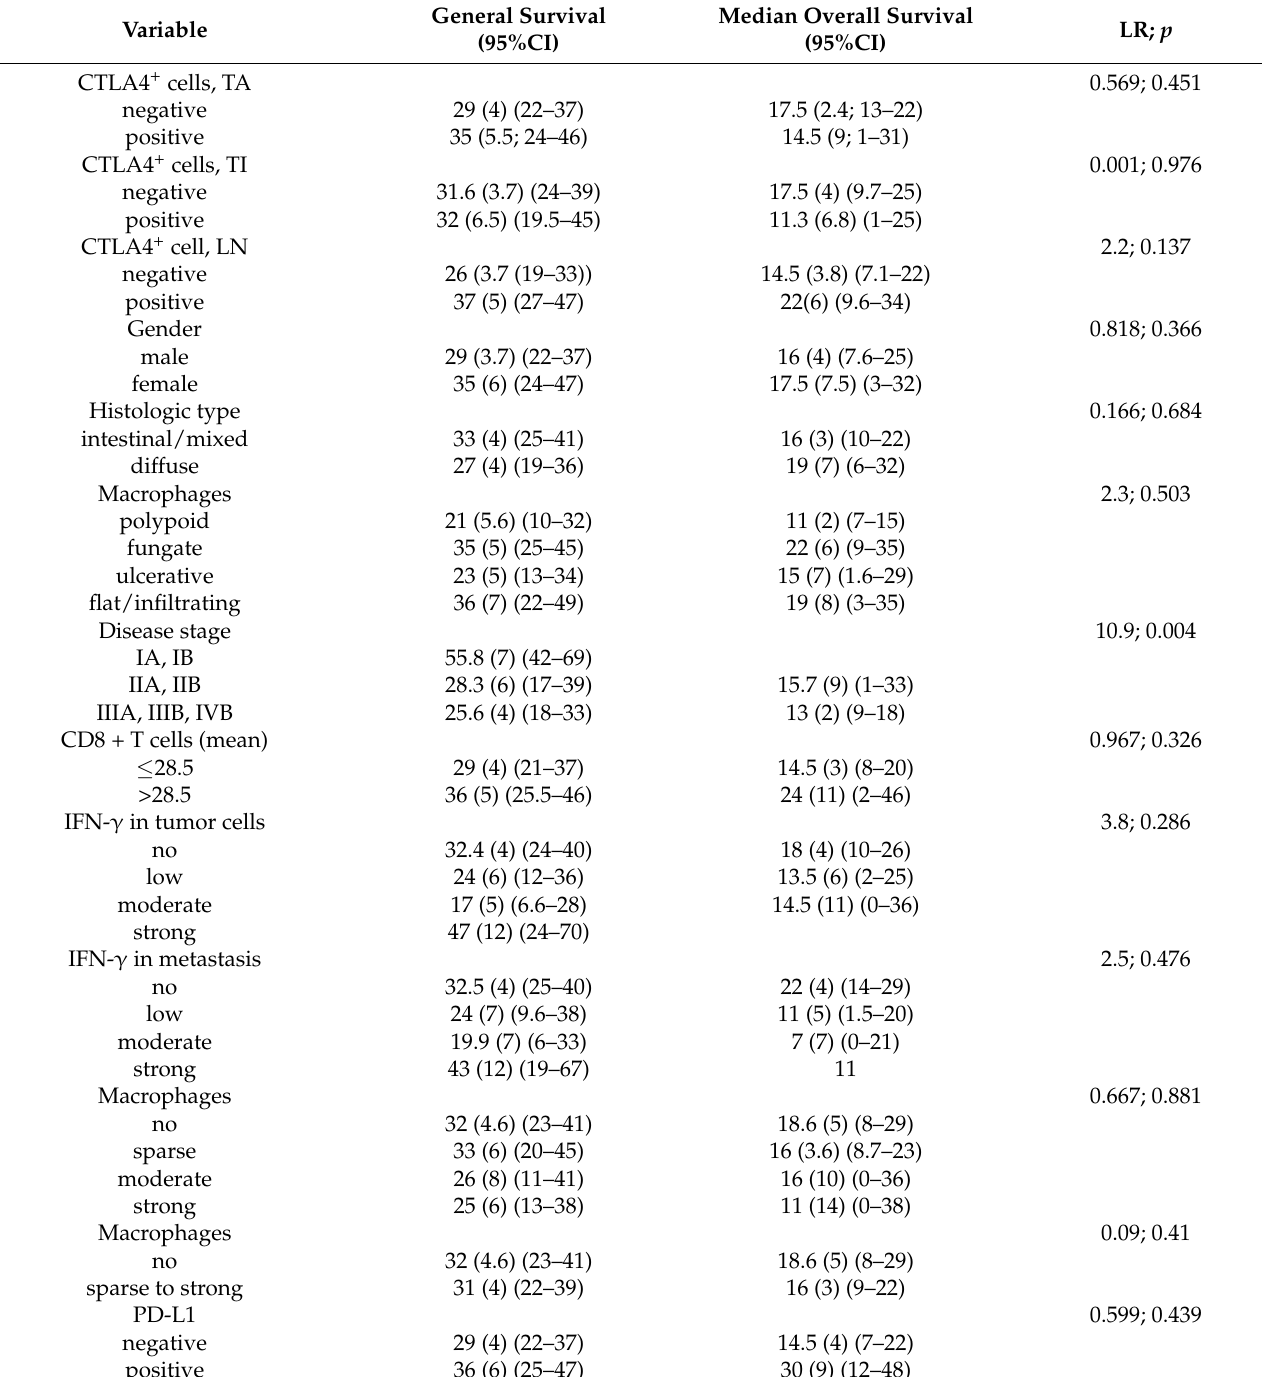
Table 7. Mean general survival and median overall survival according to analyzed parameters in patients with